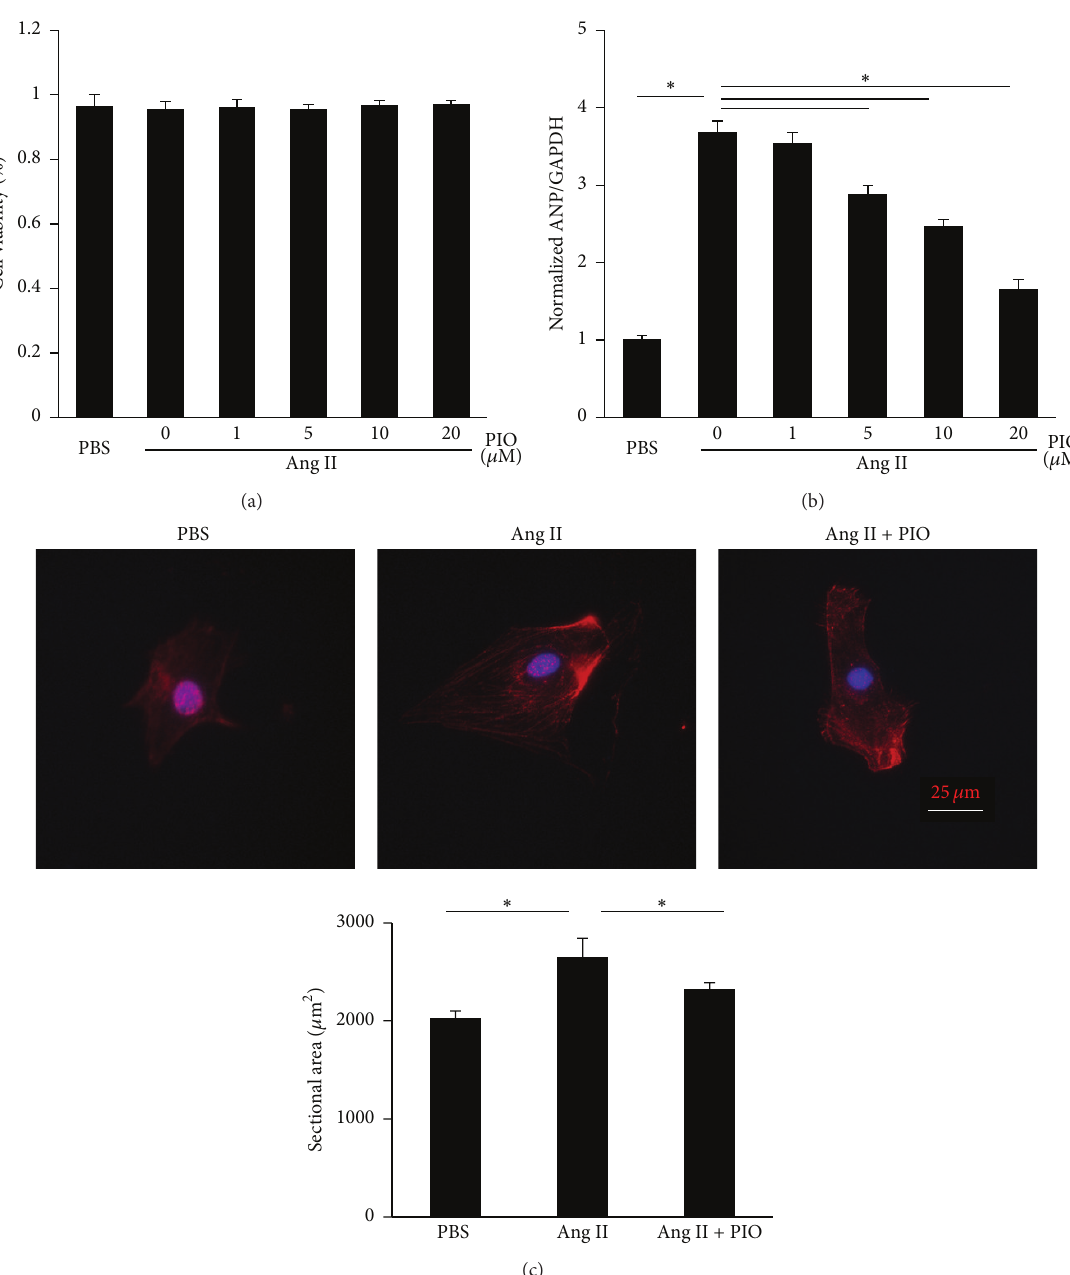
Figure4:PIOalleviatedhypertrophyofcardiacmyocytesinvitro.(a)TheeffectsofPIOonviabilityofneonatalratventricularcardiomyocytes were determined by CCK-8 in 5 independent experiments. (b) The levels of ANP of cardiomyocytes in indicated groups ( 𝑛 = 5 ). (c) The immunofluorescence of cardiomyocytes and the sectional areas of myocytes ( 𝑛 = 5 ). ∗ 𝑃 < 0.05 .